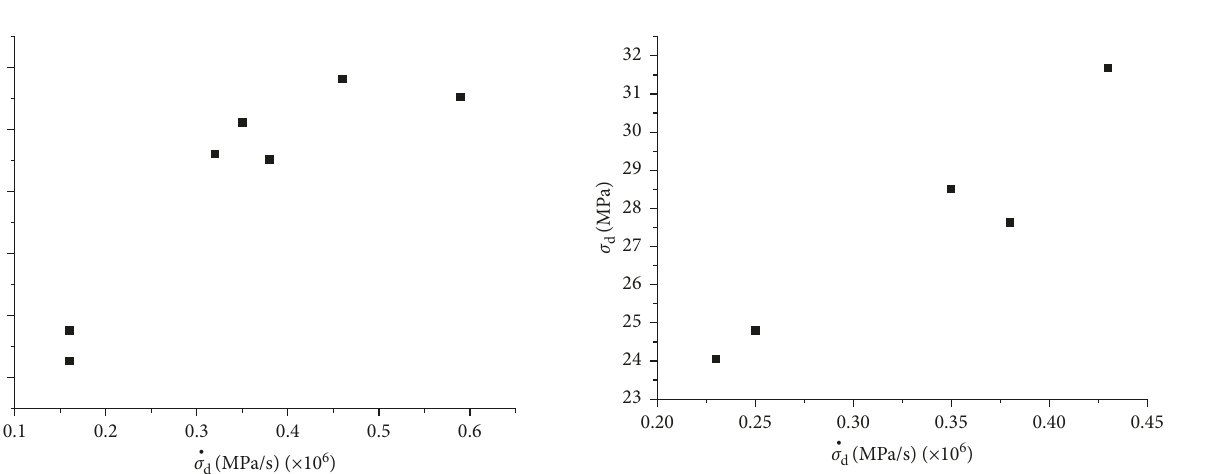
Figure 9: Relationship between dynamic tension strength and loading rate at depth 520m.